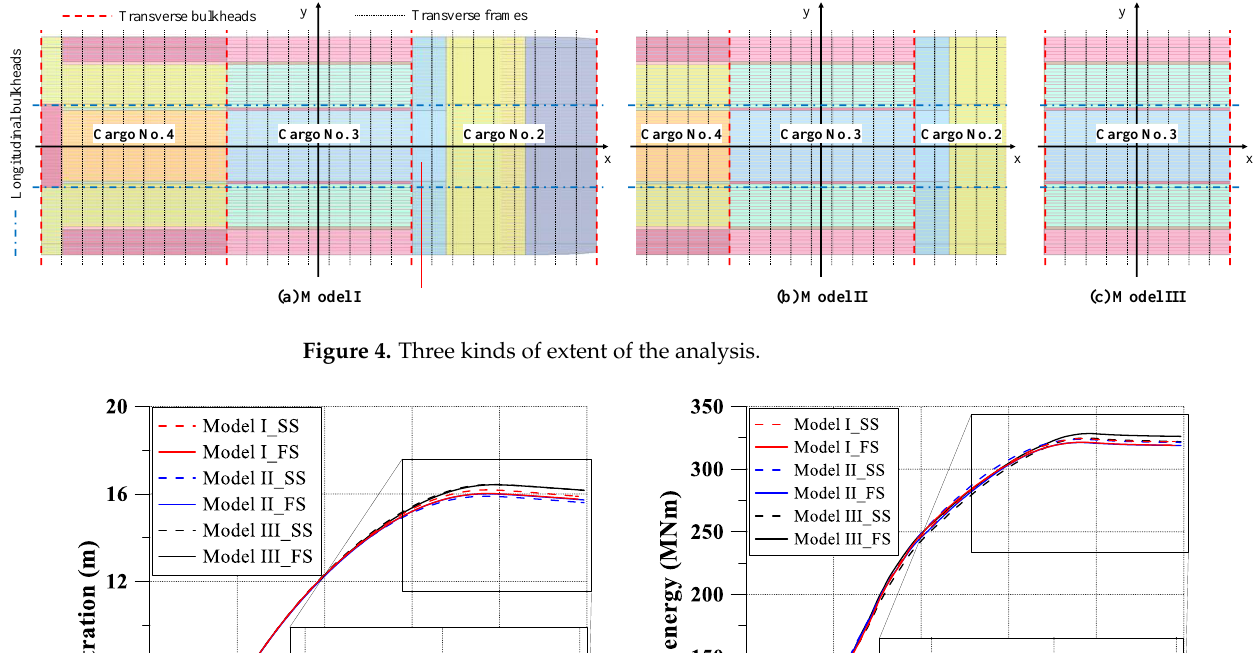
Figure 4. Three kinds of extent of the analysis.